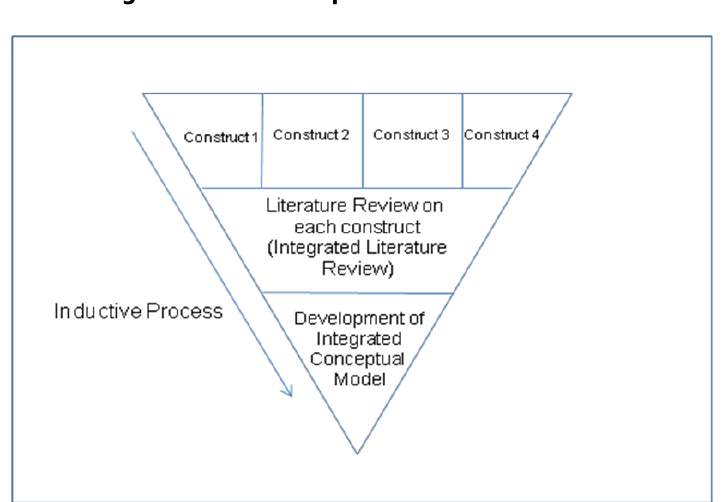
Figure 1: Research